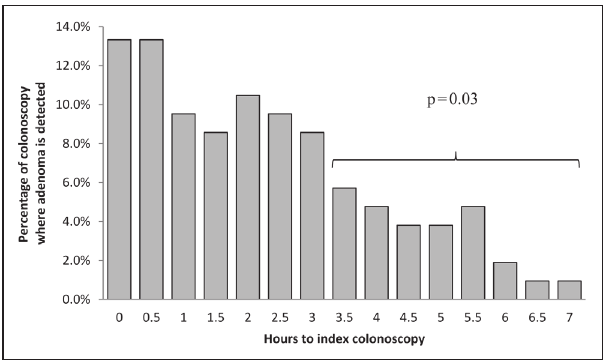
Figure 1) Percentage of colonoscopies in which adenomas were detected from the beginning of the endoscopy session (h)